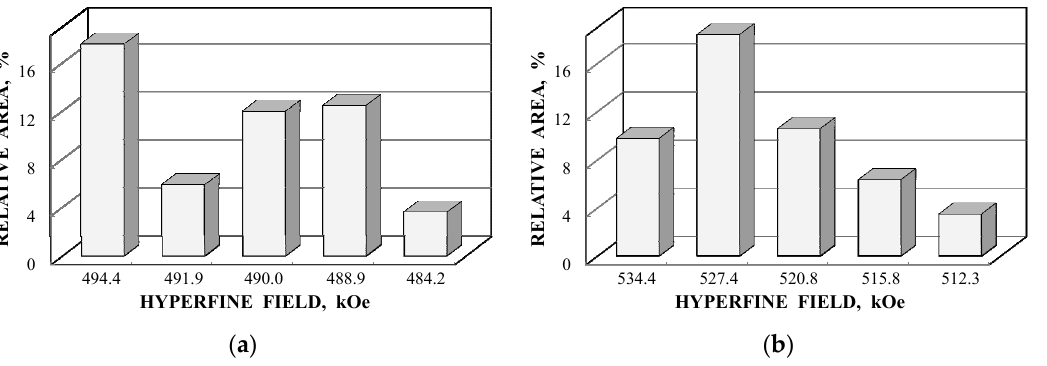
Figure 58. Histograms of the relative area variation for the magnetic sextets with decrease in H eff at the 57 Fe nuclei resulting from the different numbers of Ni 2+ cation in the Fe 3+ local microenviron ‐ ments in both tetrahedral ( a ) and octahedral ( b ) sites of NiFe 2 O 4 nanoparticles in sample N1. Histograms for magnetic sextets obtained in the Mössbauer spectrum of sample N1 are different from those shown in Figure 53a,c,e,g. This may be a result of different sample preparations, deviation from stoichiometry, larger particle size (150 vs. 25 nm or 35 nm), internal inhomogeneity leading to larger deviations from the calculations for the ideal crystal structure and some other factors. Nevertheless, the Mössbauer spectra of three samples of NiFe 2 O 4 nanoparticles (NA, NB and N1) measured with a high velocity resolution were better fitted using a new physical model accounting for the different probabilities of various numbers of Ni 2+ cations in the 57 Fe local microenvironments in both (A) and [B] sites in spinel crystals.